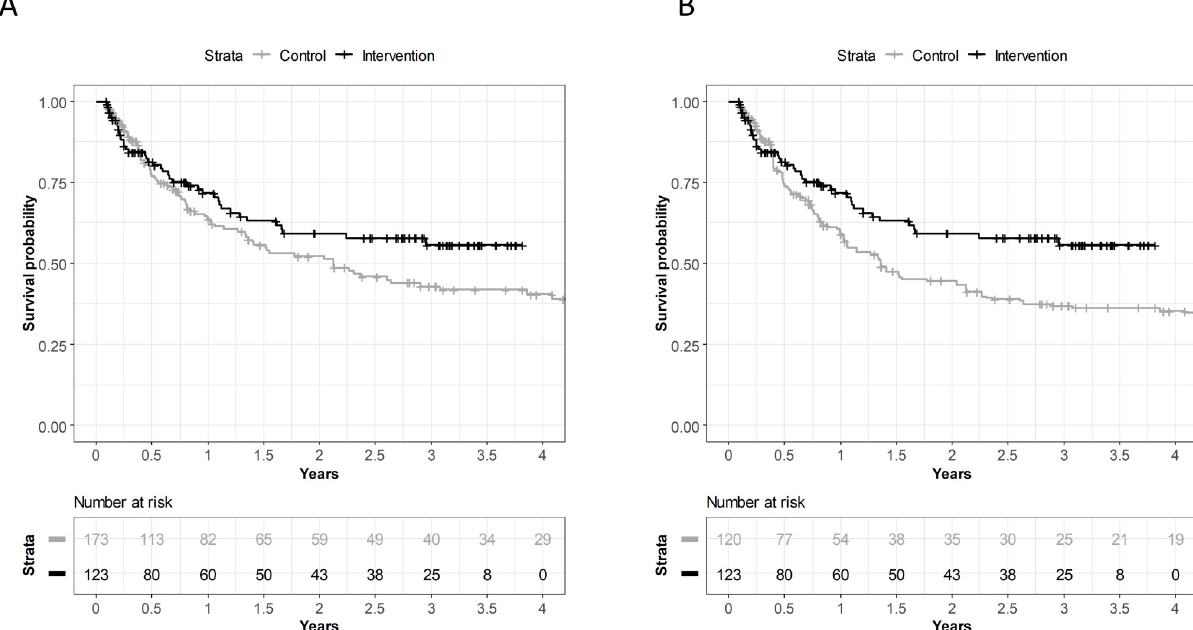
Fig 2. Kaplan-Meier plots of overall survival of NSCLC patients. A, unweighted data; B, weighted data. In panel B, the sample size represents the rounded sum of weights.